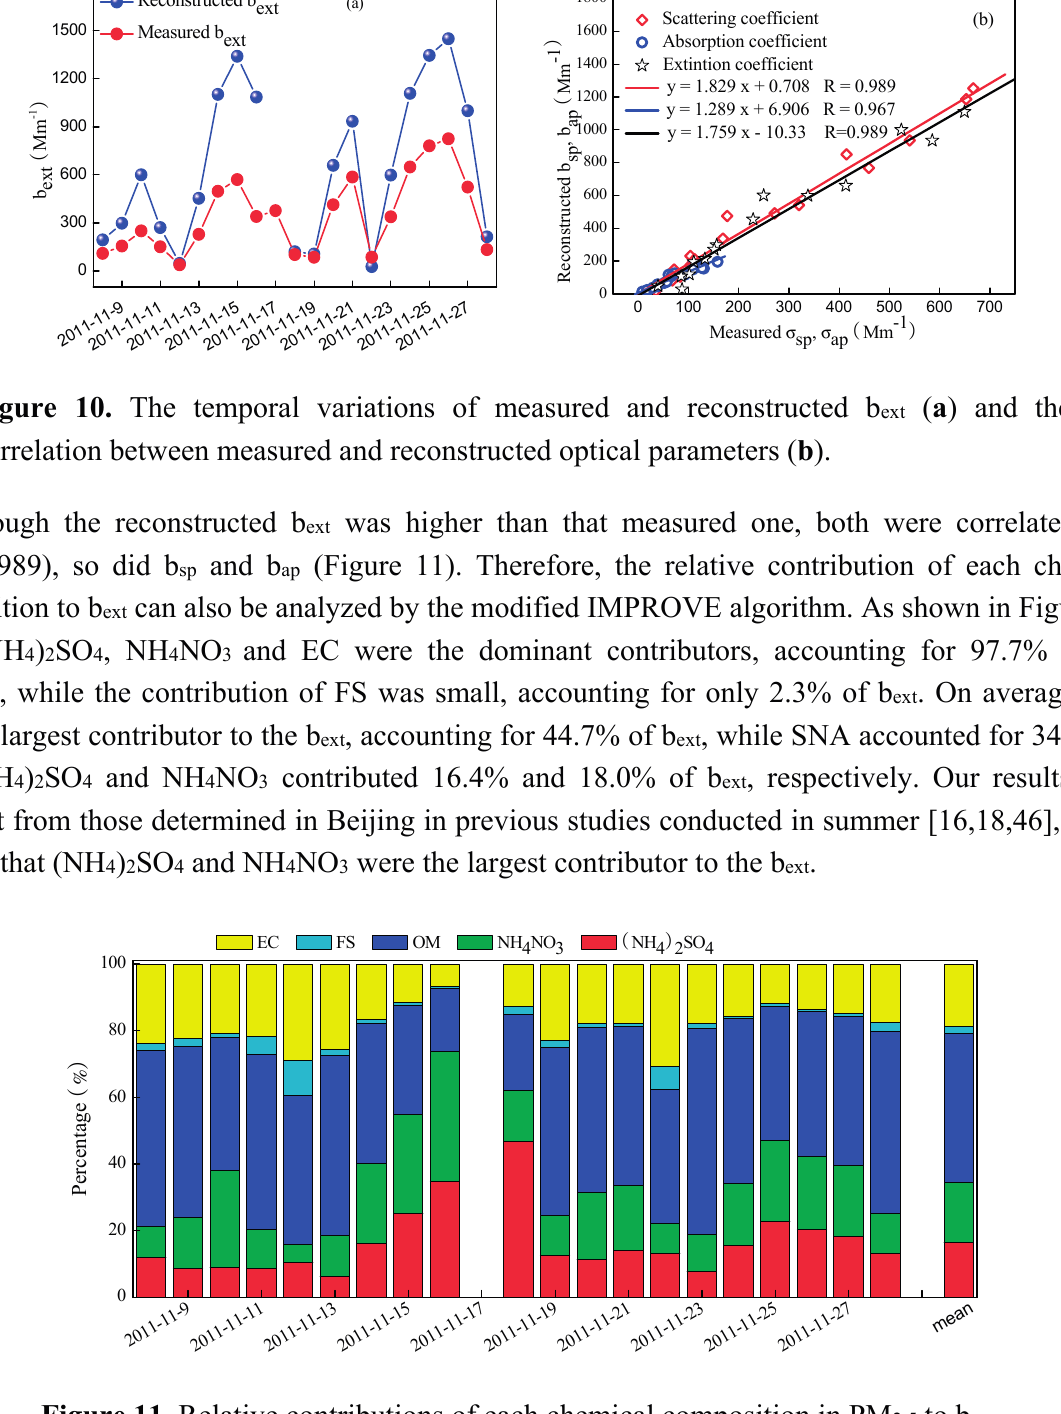
Figure 11. Relative contributions of each chemical composition in PM 2.5 to b ext